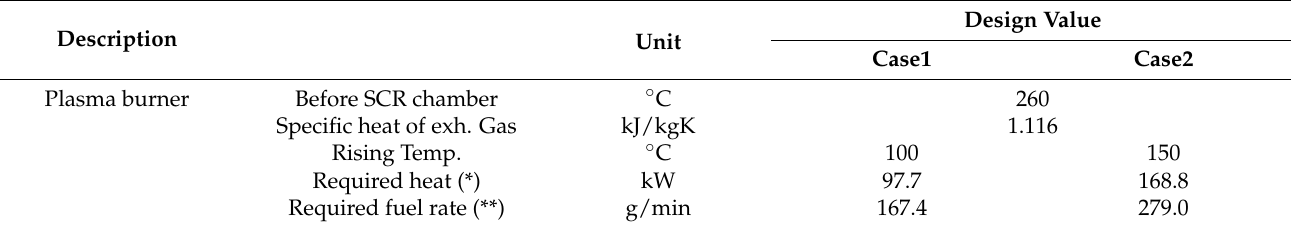
Table 5. Experimental conditions for plasma burner performance.